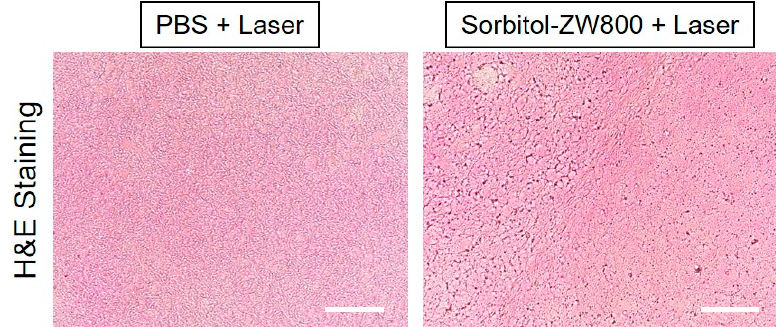
Figure 6. Tumor H & E-stained slices of PBS and sorbitol–ZW800 injected mice at 24 h after laser irradiation. Scale bars = 100 µm.